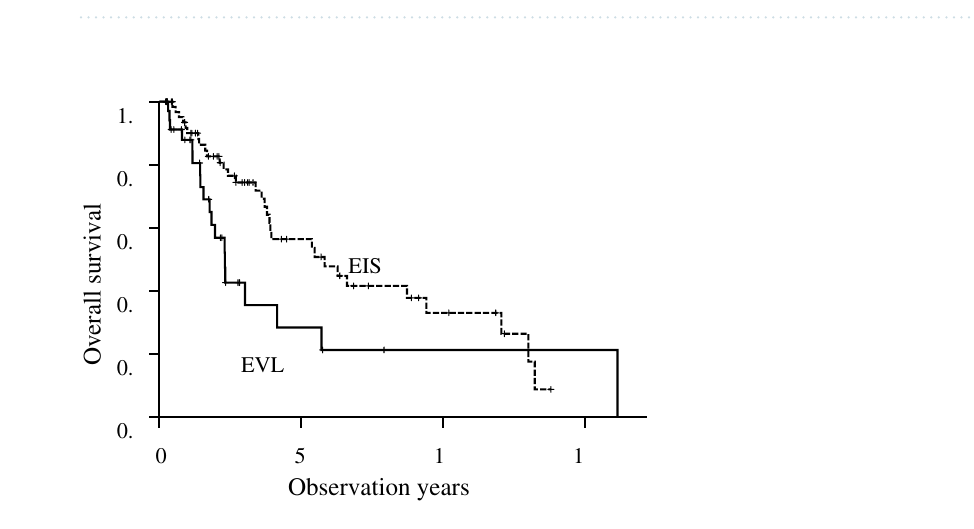
Figure 1. Overall survival in patients in the EIS group (dotted line) and EVL group (solid line). The EIS group showed a better prognosis than the EVL group (5 years survival rate: 56.5% vs 28.4%, p =